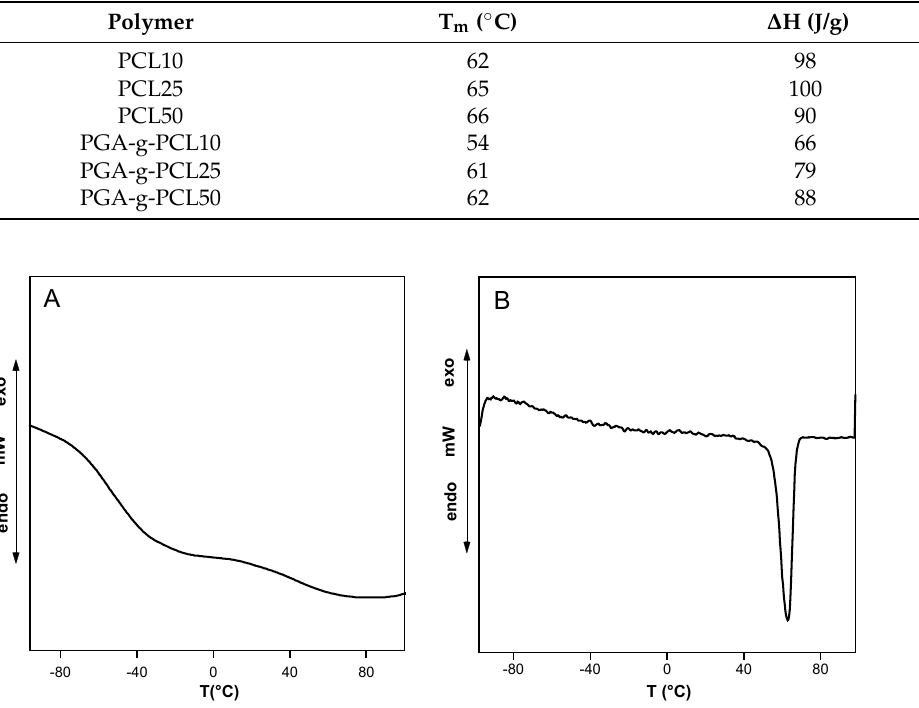
Table 1. Melting temperature (T m ) and melting enthalpy ( ∆ H) of the PCL homopolymers and PGA-g-PCL copolymers.